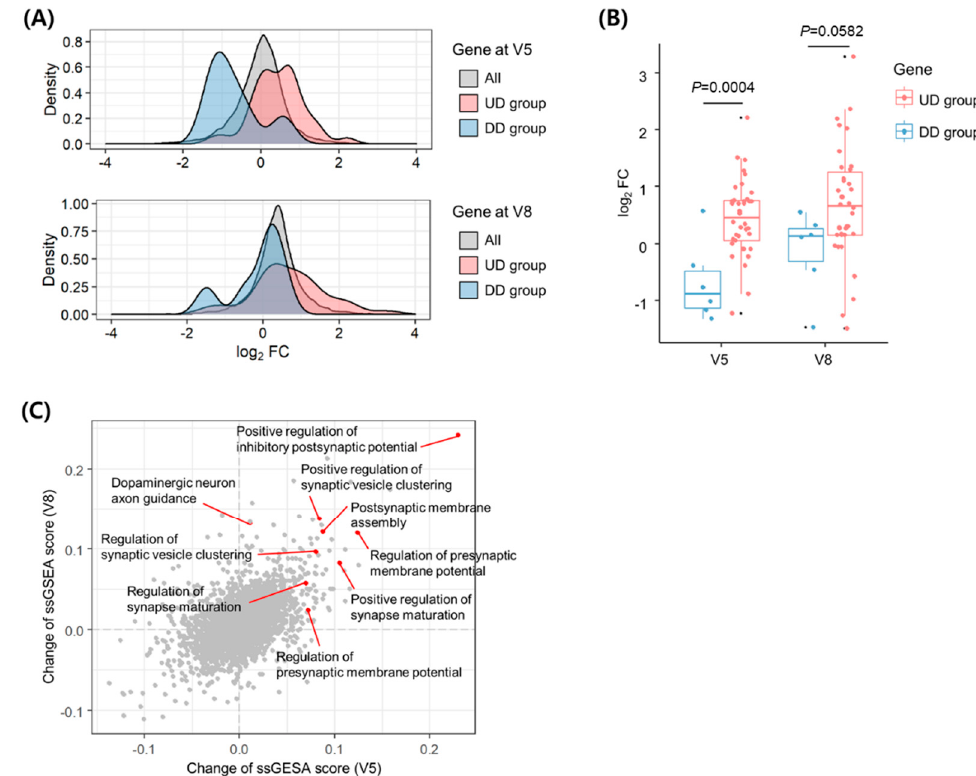
Figure 2. Transcriptomic alterations in the blood of the representative patient with PD. ( A ) Distributions of expression fold-changes for all genes, DD group, and UD group at V5 and V8 compared to V1. The density was defined as the proportion of genes with a specific fold change among all genes. ( B ) Comparison of the expression changes between genes in the UD and DD groups at V5 and V8 compared to V1. P − values were determined using the two-tailed Students’ t -test. ( C ) Changes in ssGSEA scores for the GO BP gene set at V5 and V8 compared to V1. Each point represents a changed set of scores in pathways of the gene set. The enriched pathways related to synapse transmission are indicated by red arrows. FC, fold change; ssGSEA, single-sample gene set enrichment analysis; UD, upregulated genes by dopaminergic therapy; DD, downregulated genes by dopaminergic therapy; PD, Parkinson’s disease.